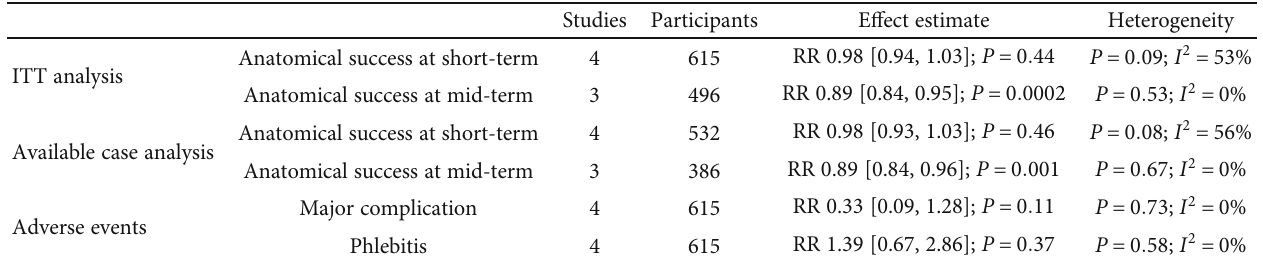
Table 3: Summary of fi ndings.